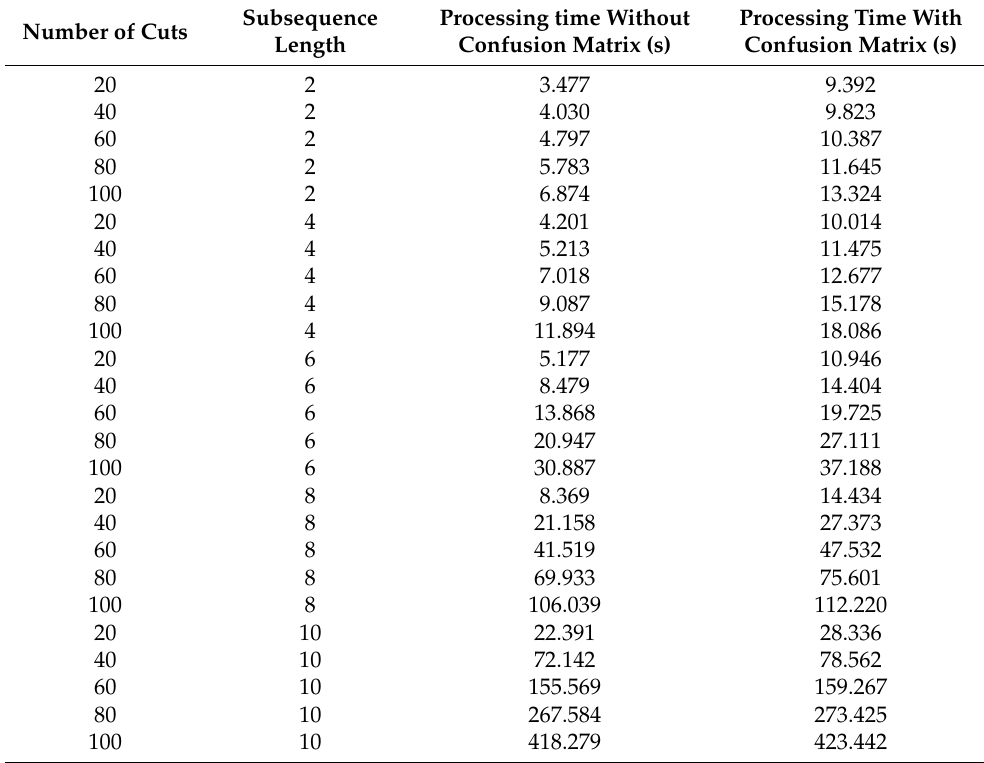
Table 5. Program processing time for the K-mer-based machine learning models.